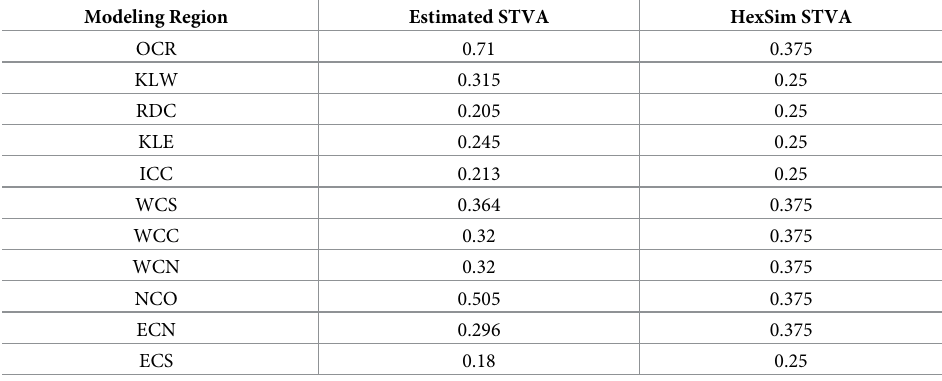
Table 10. Barred owl (STVA) encounter rates by modeling